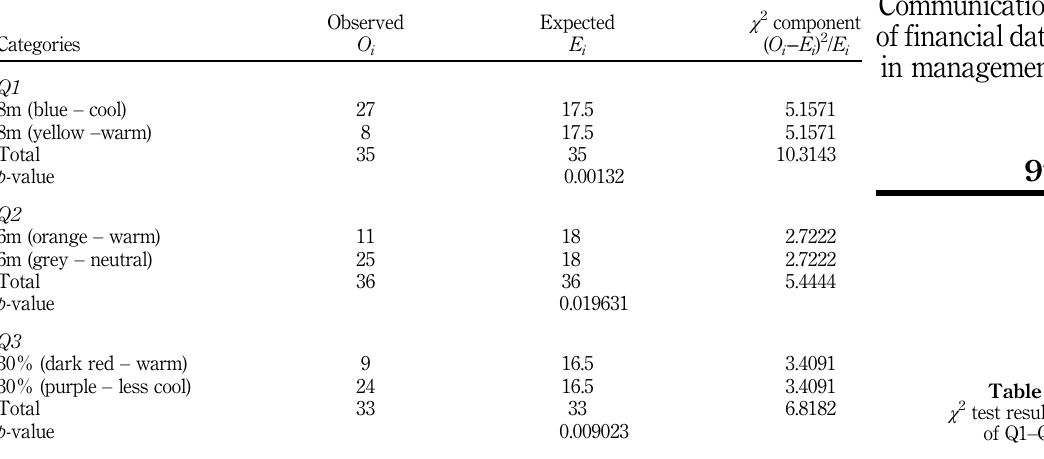
Table I. χ 2 test